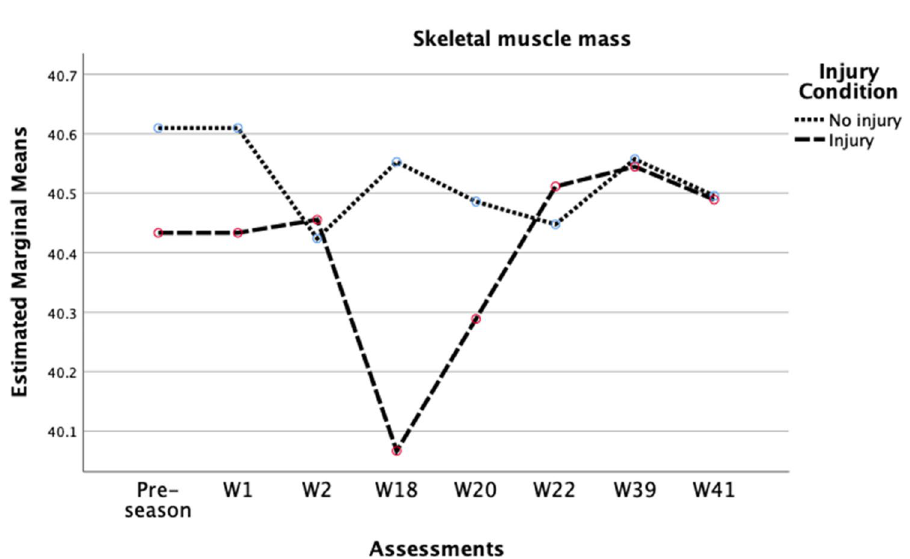
Figure 4. Variation in players’ skeletal muscle mass across the season